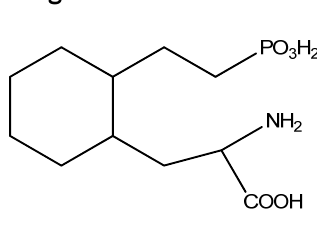
Figure 13. NPC 17742.